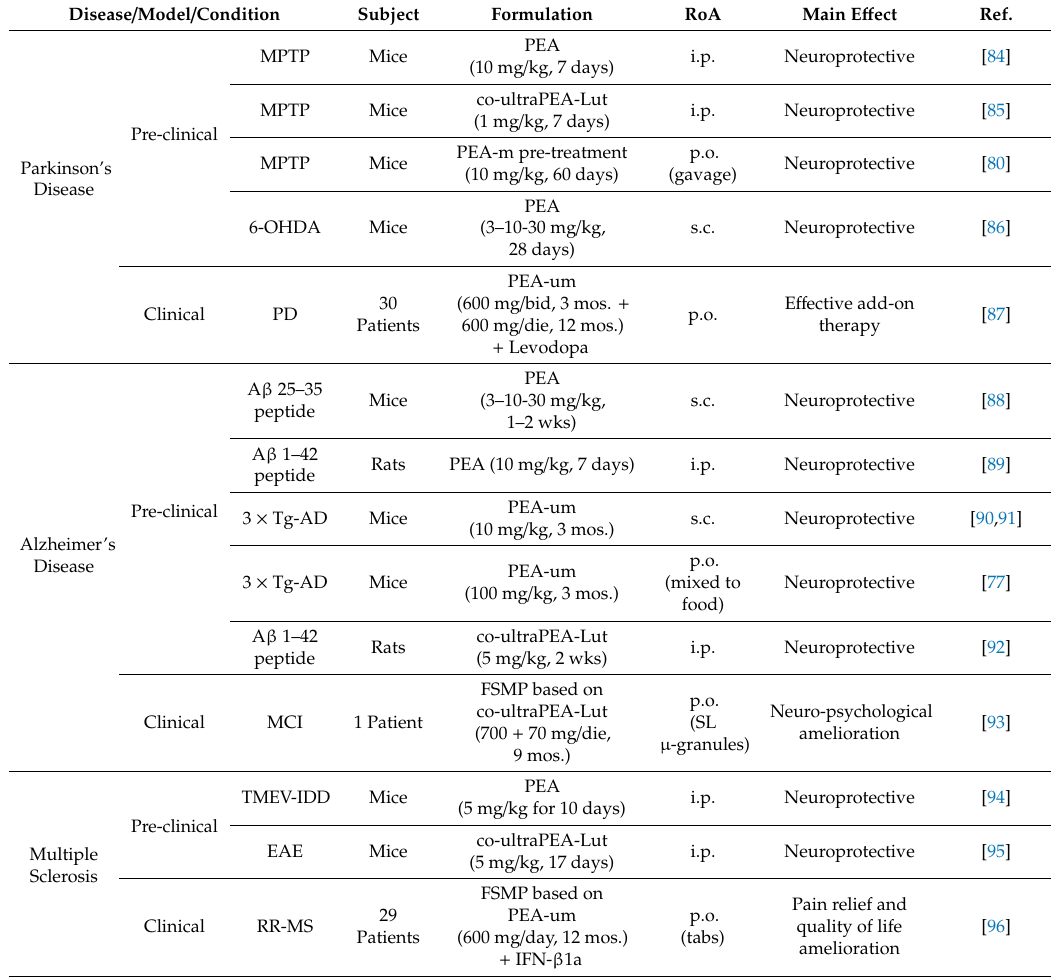
Table 2. Pre-clinical and clinical e ff ects of PEA in micronized and co-micronized formulations on neuroinflammation associated with neurodegenerative and neurological disorders. Abbreviations: A β , beta amyloid; ALS, amyotrophic lateral sclerosis; ASD, autism spectrum disorders; bid, twice a day; co-ultraPEA-Lut, PEA co-ultra-micronized with Luteolin; EAE, experimental autoimmune encephalomyelitis; FSMP, Foods for Special Medical Purposes; i.h., intra-hippocampal; i.p., intra-peritoneal; MCI, mild cognitive impairment; MG, myasthenia gravis; mos., months; MPTP, 1-methyl-4-phenyl-1 2 3 6-tetrahydropyridine; PEA, palmitoylethanolamide; PEA-m: micronized